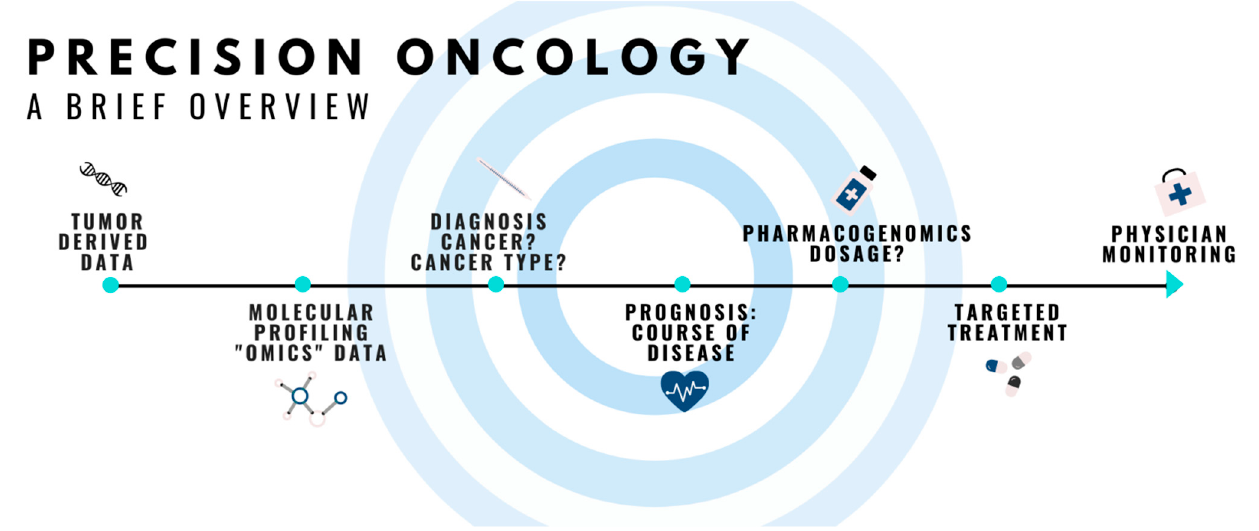
Figure 1. Overview of precision